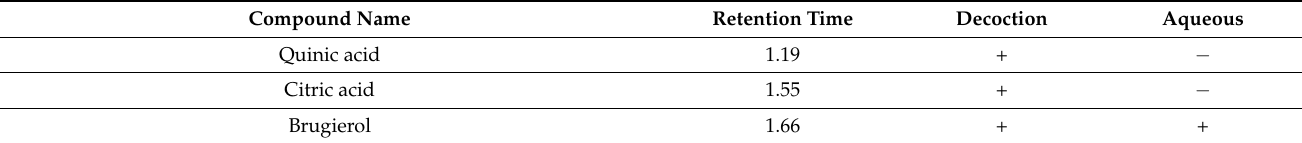
Table 5. Chemical composition of twig